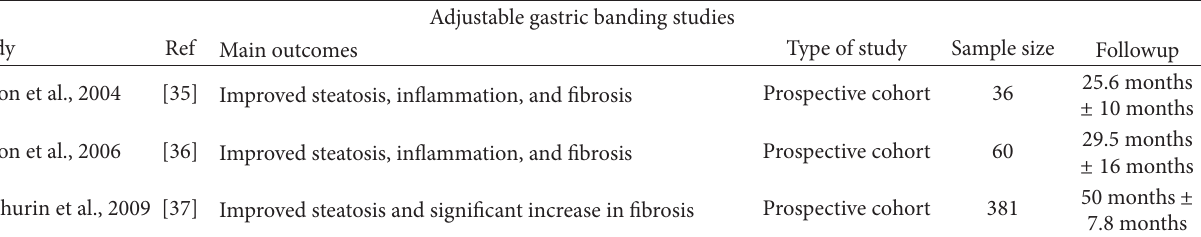
T 3: Summary of studies of AGB and their effect on NAFLD.